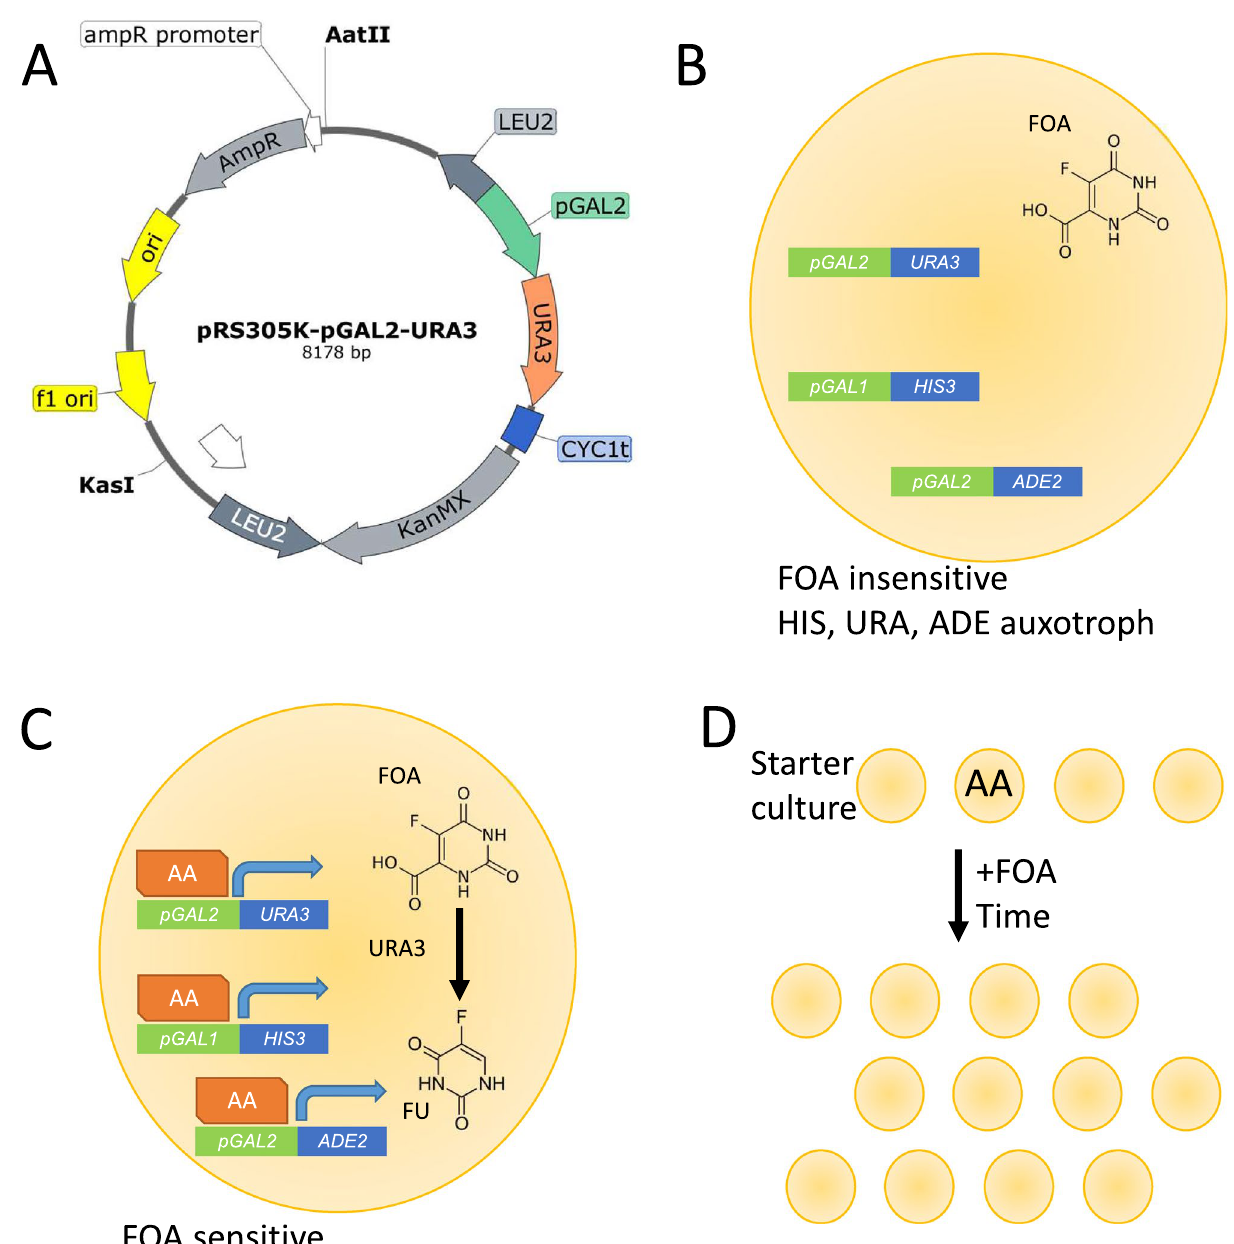
Figure 1. Synthesized pGAL2-URA3 plasmid and outline of the method. ( A ) pRS305k-pGAL2-URA3 plasmid harboring URA3 driven by pGAL2 promoter. ( B ) Scenario where the yeast cell does not contain an auto- activator (AA). URA3 and HIS3 are not expressed, and FOA is not converted into FU. ( C ) Scenario where an AA activates the expression of URA3 and HIS3 , resulting in the conversion of FOA into toxic FU by URA3 . ( D ) Description of the AA-removal method, where a starter culture containing AAs is treated by FOA. Since FOA can inhibit or kill yeast, the growth of AAs should be severely delayed or outright stopped by of yeast strains used in CrY2H-seq 13 , which use a Cre recombinase to fuse in vivo the coding sequences of two interacting proteins, allowing to identify these interactions with next-generation DNA sequencing. A yeast strain containing this new fragment in the presence of FOA, but with the absence of an auto-activator, would not express HIS3 and URA3 and would be FOA insensitive and histidine auxotrophic (Fig. 1B). Conversely, in the presence of an auto-activator, both HIS3 and URA3 would be expressed, and the yeast would be histidine and uracil autotroph and sensitive to FOA (Fig. 1C). We hypothesize that by adding FOA to the media before the mating, growth of haploid yeast cells that express URA3 should be inhibited (Fig. 1D), due to the accumulation of the toxic FU in the yeast cells. This should reduce